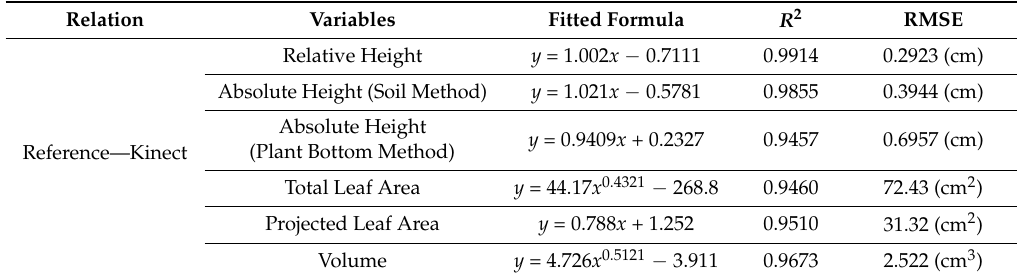
Table 3. Details of the fitting results for reference—Kinect data and Kinect—biomass